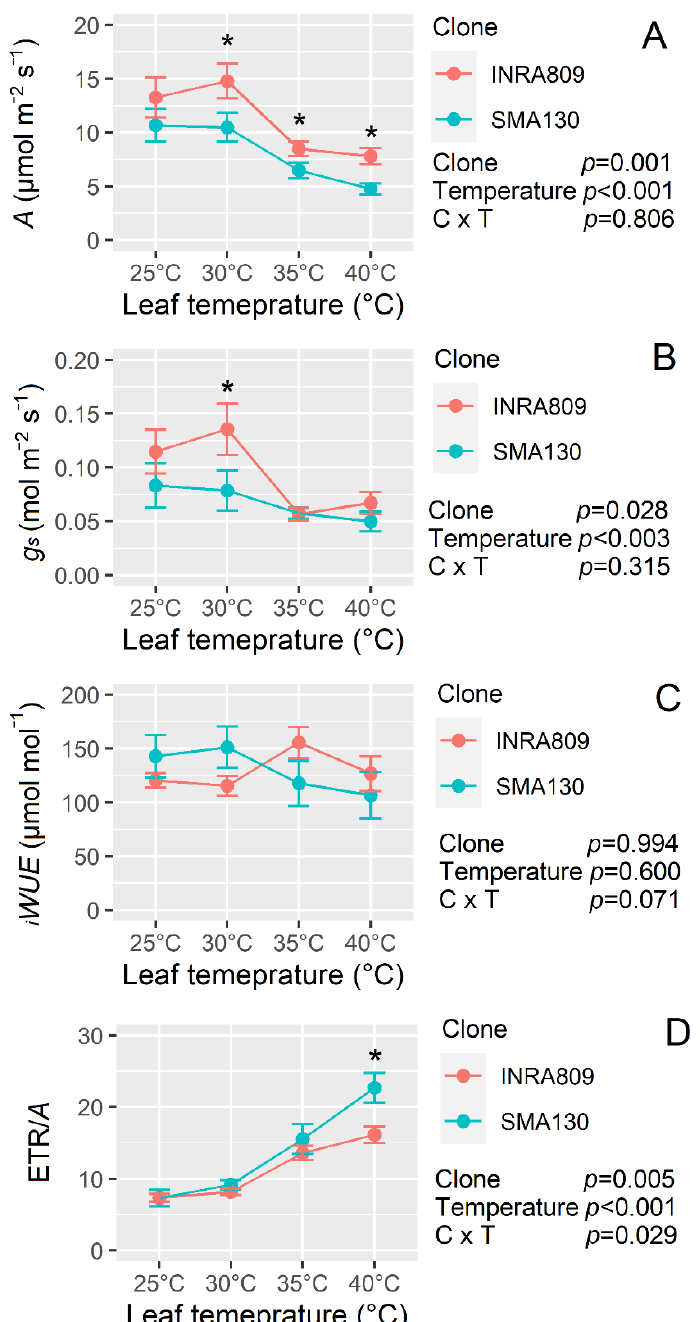
Figure 6. Temperature response of two grapevine clones (INRA809 and SMA130) for CO 2 assimilation ( A , A ), stomatal conductance ( g s , B ), intrinsic water-use efficiency ( i WUE , C ) and the ratio between ETR and A (ETR/ A , D ). Data were collected with a Licor6400 and at increasing leaf temperatures (25, 30, 35, 40 ◦ C). Data are means ( n = 5) ± standard error of the means (SEM). Data were collected on 6 August 2019 and subjected to two-way ANOVA (output in the graph). Asterisks show significant differences between clones according to t -test.